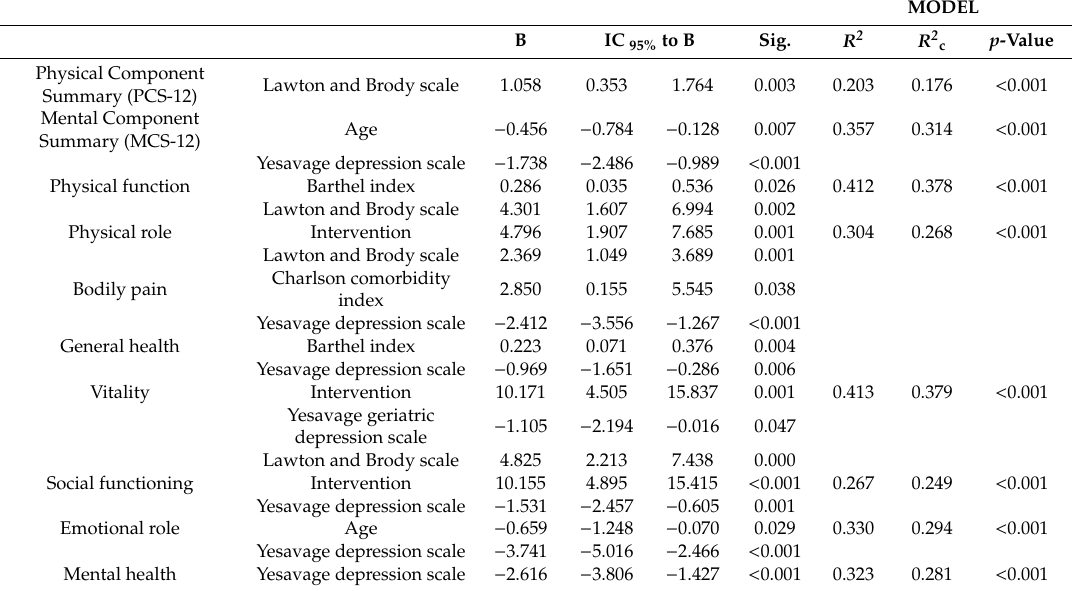
Table 4. Multiple regression analysis of factors influencing dimensions of the SF-12 questionnaire at 12 months after the surgical